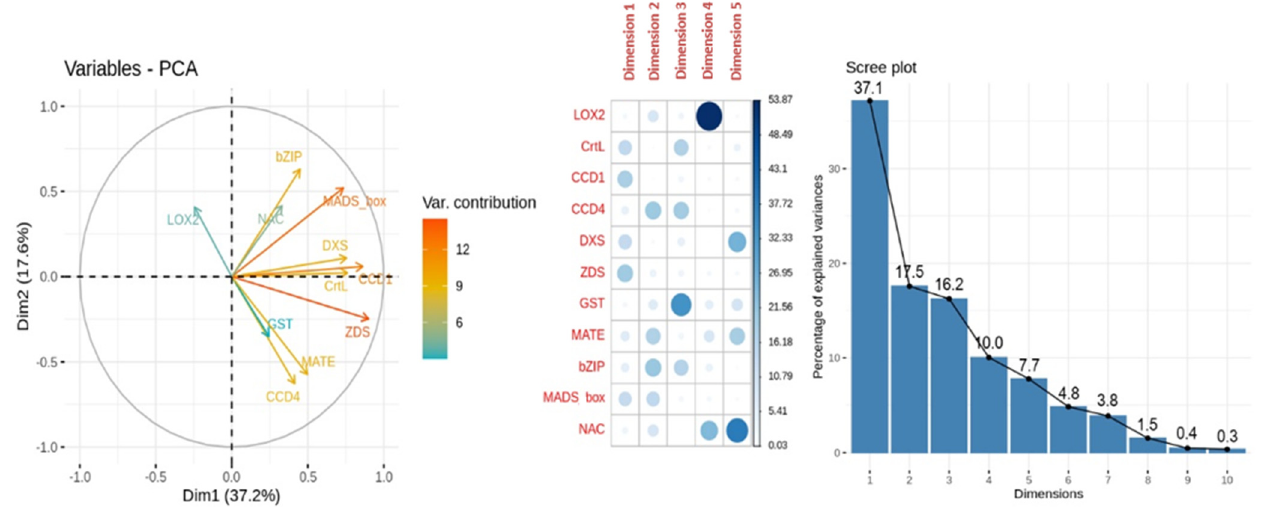
Figure 12 . Principal Component Analysis (PCA) of relative expression from carotenoids content MLR model. From left to right: representation of the variable contribution to dimensions 1 (Dim1) and 2 (Dim2), variable contribution and dimension correlation with the first five dimensions and percentage of explained variance of the first ten dimensions performed over the relative expression of the genes involved in carotenoid biosynthesis ( bZIP, CCD1, CCD4, CrtL, DXS, GST, MATE, MADS-box, NAC, LOX2 and ZDS ) evaluated in apricot fruit during the ripening progression in the nine cultivars ‘Bergeron’, ‘Cebasred’, ‘Currot’, ‘Dorada’, ‘Estrella’, ‘Goldrich’, ‘Moniquí’, ‘Valorange’ and ‘Z108-38 ′ at three ripening stages green fruit, during color change and at physiological ripening.